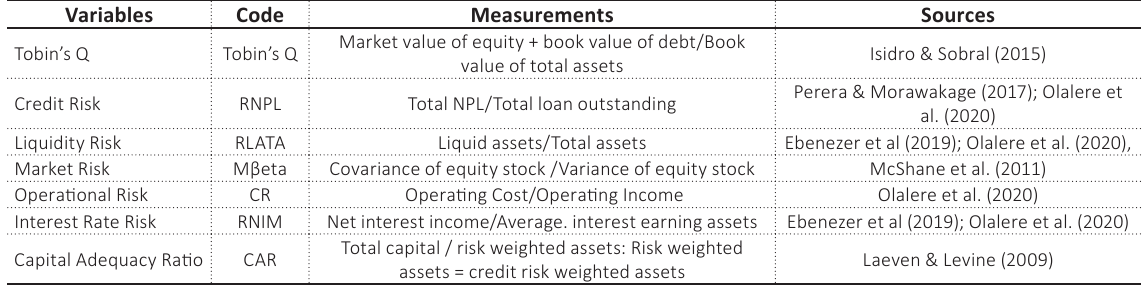
Table 2. Summary of variables and